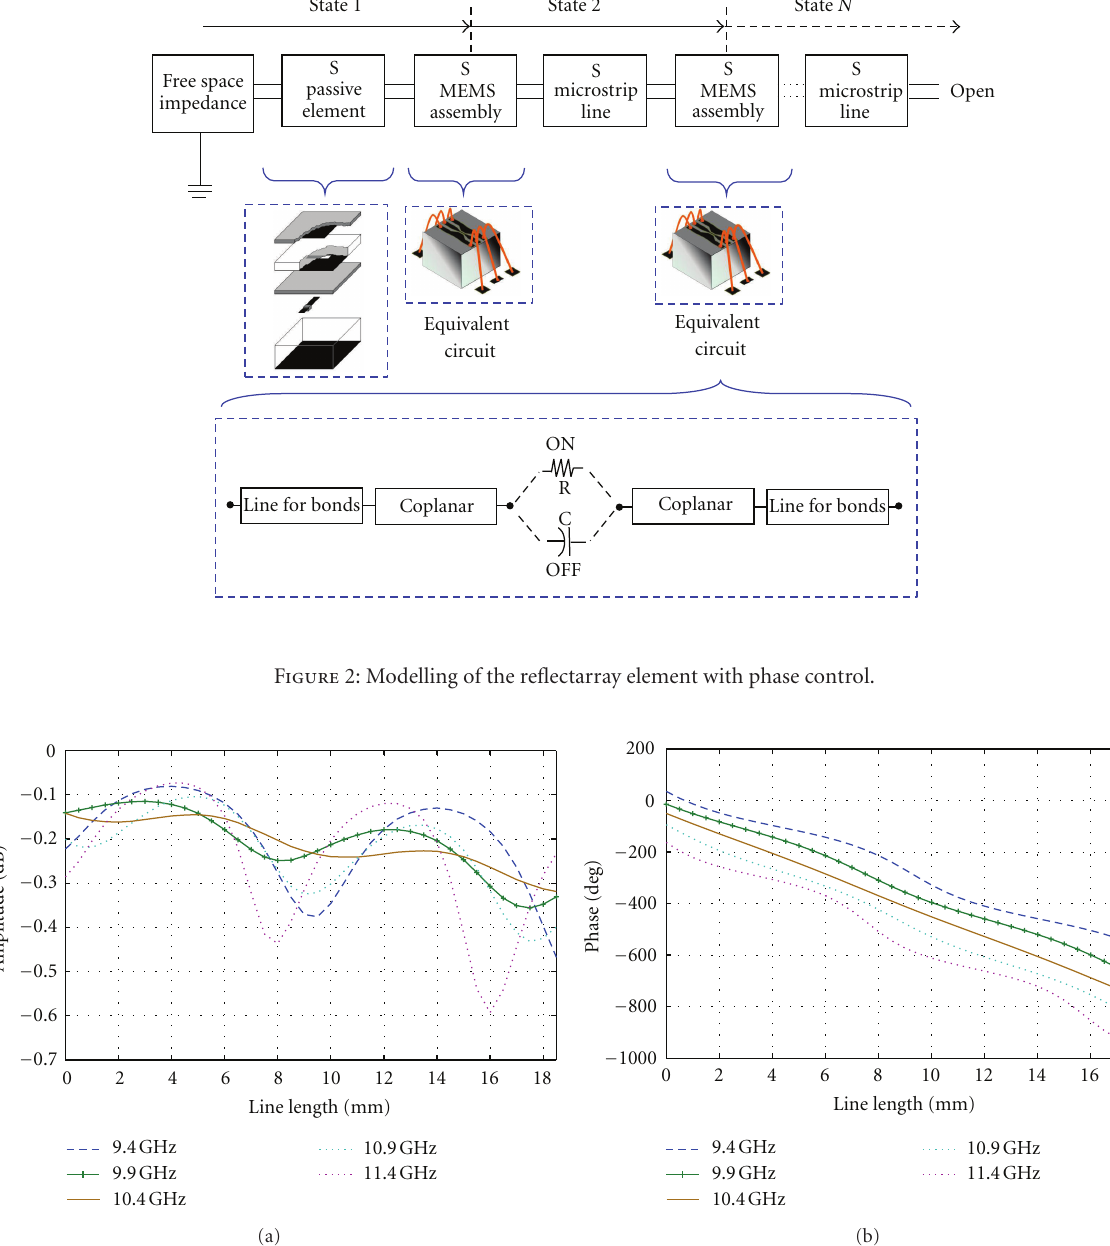
Figure 3: Reflection coe ffi cient in free space for the passive single element as a function of the delay line length. (a) Amplitude. (b) Phase.